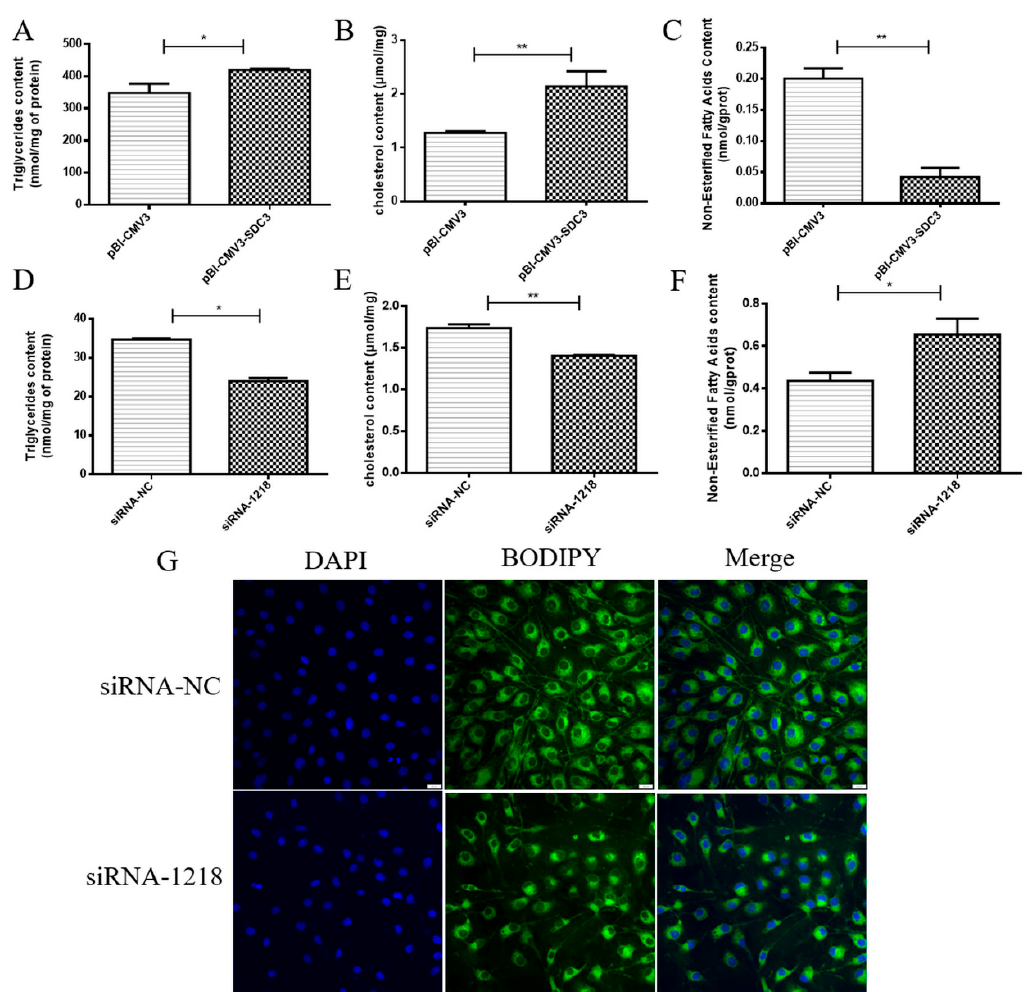
Figure 2. Effects of SDC3 on milk fat synthesis. The vectors (pBI-CMV3, pBI-CMV3-SDC3) and siRNAs (siRNA-NC, siRNA-1218) were transfected into BMECs for 24 h. Triglyceride ( A , D ), choles- terol ( B , E ) and non-esterified fatty acid ( C , F ) kits were used to measure milk fat synthesis in BMECs, whereas BODIPY staining ( G ) was used to observe milk fat in BMECs. Data presented as means ± SD (n = 3). Statistically significant differences are indicated: * p < 0.05, ** p < 0.01. pBI-CMV3, siRNA-NC = nonspecific scrambled control. Scar bar = 20 µ